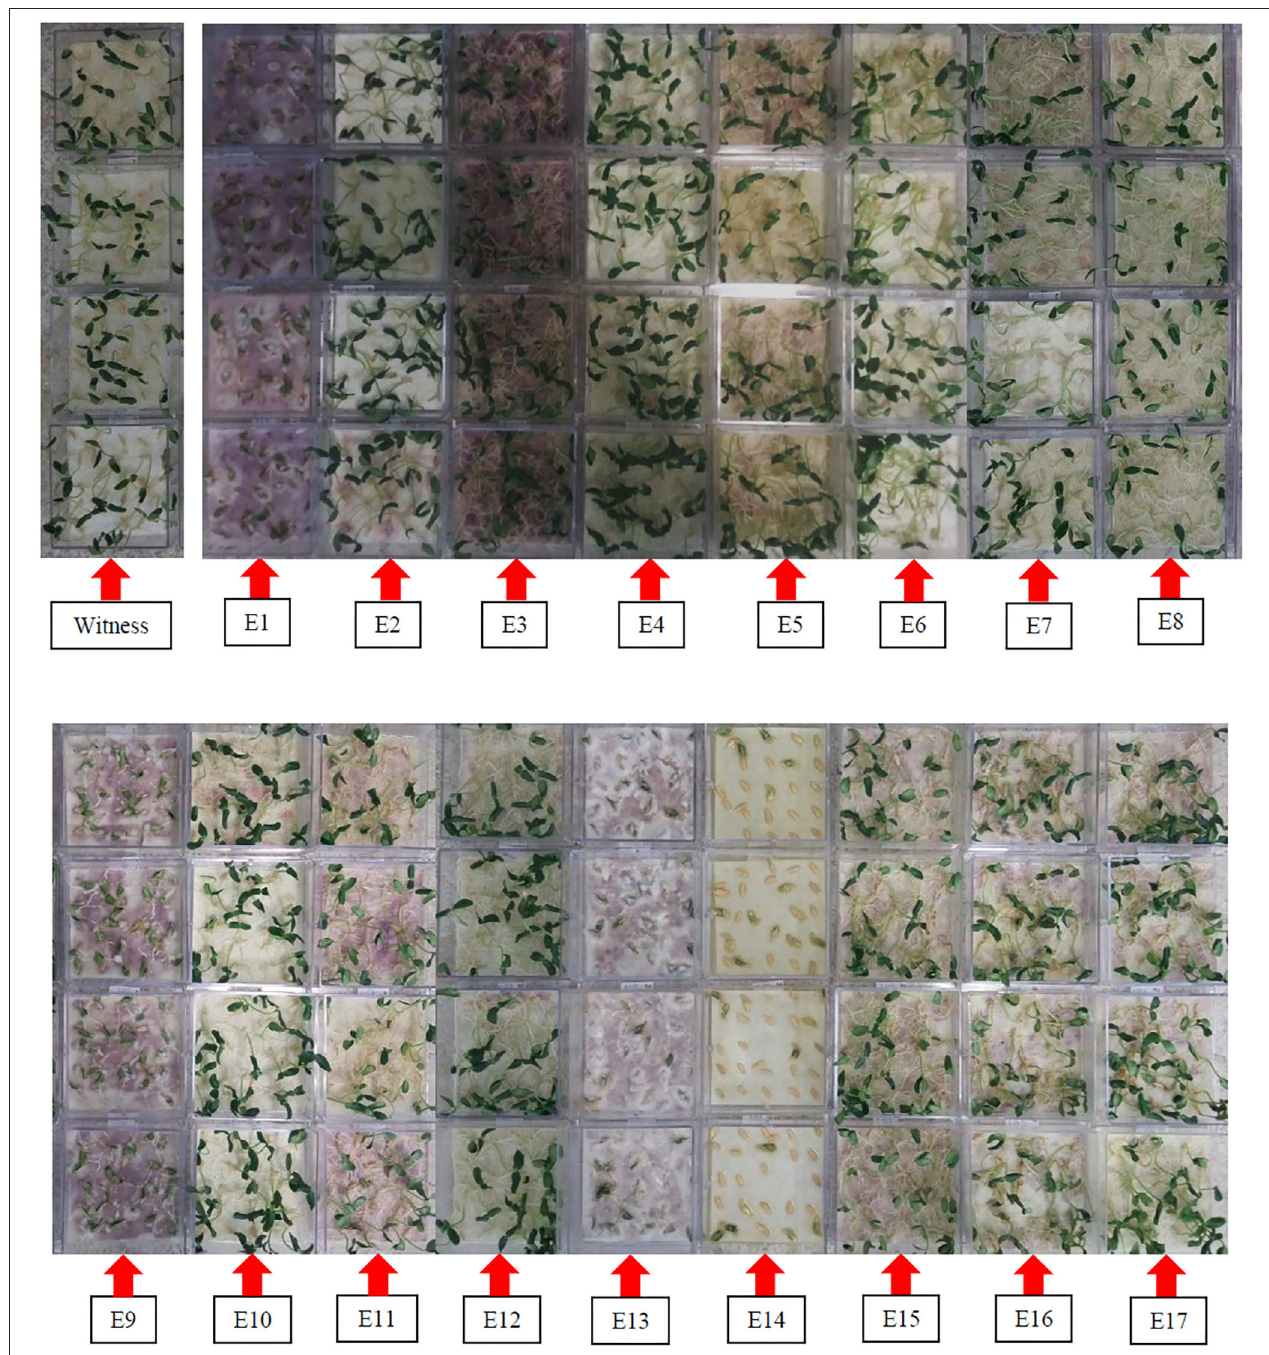
FIGURE 3 | Results of the application of biocompounds produced in pre-emergence of Cucumis